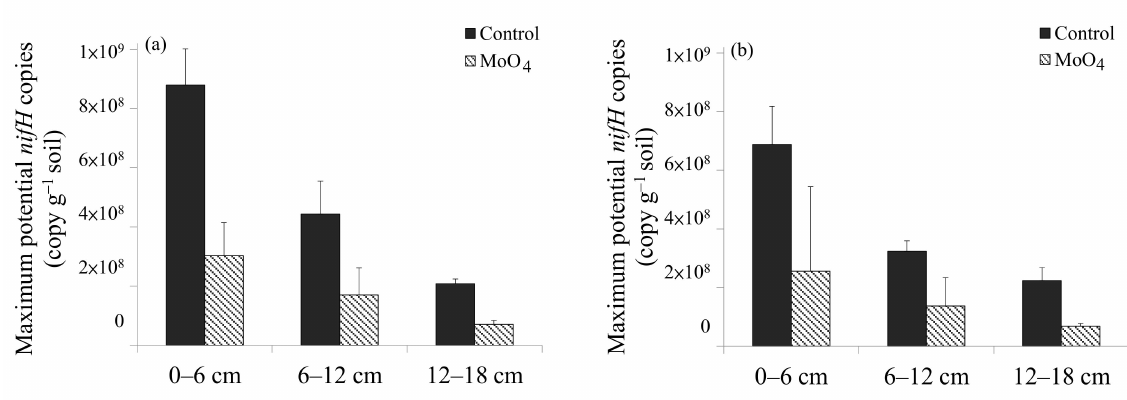
Figure 5. The number of nitrogenase gene (i.e., nifH gene) copies in Guandu ( a ) and Bali ( b ) mangrove forest soils amended with glucose, and with or without MoO 4 added, at the three soil depths. The height of bars and the error bars indicate the mean and standard deviation, respectively.